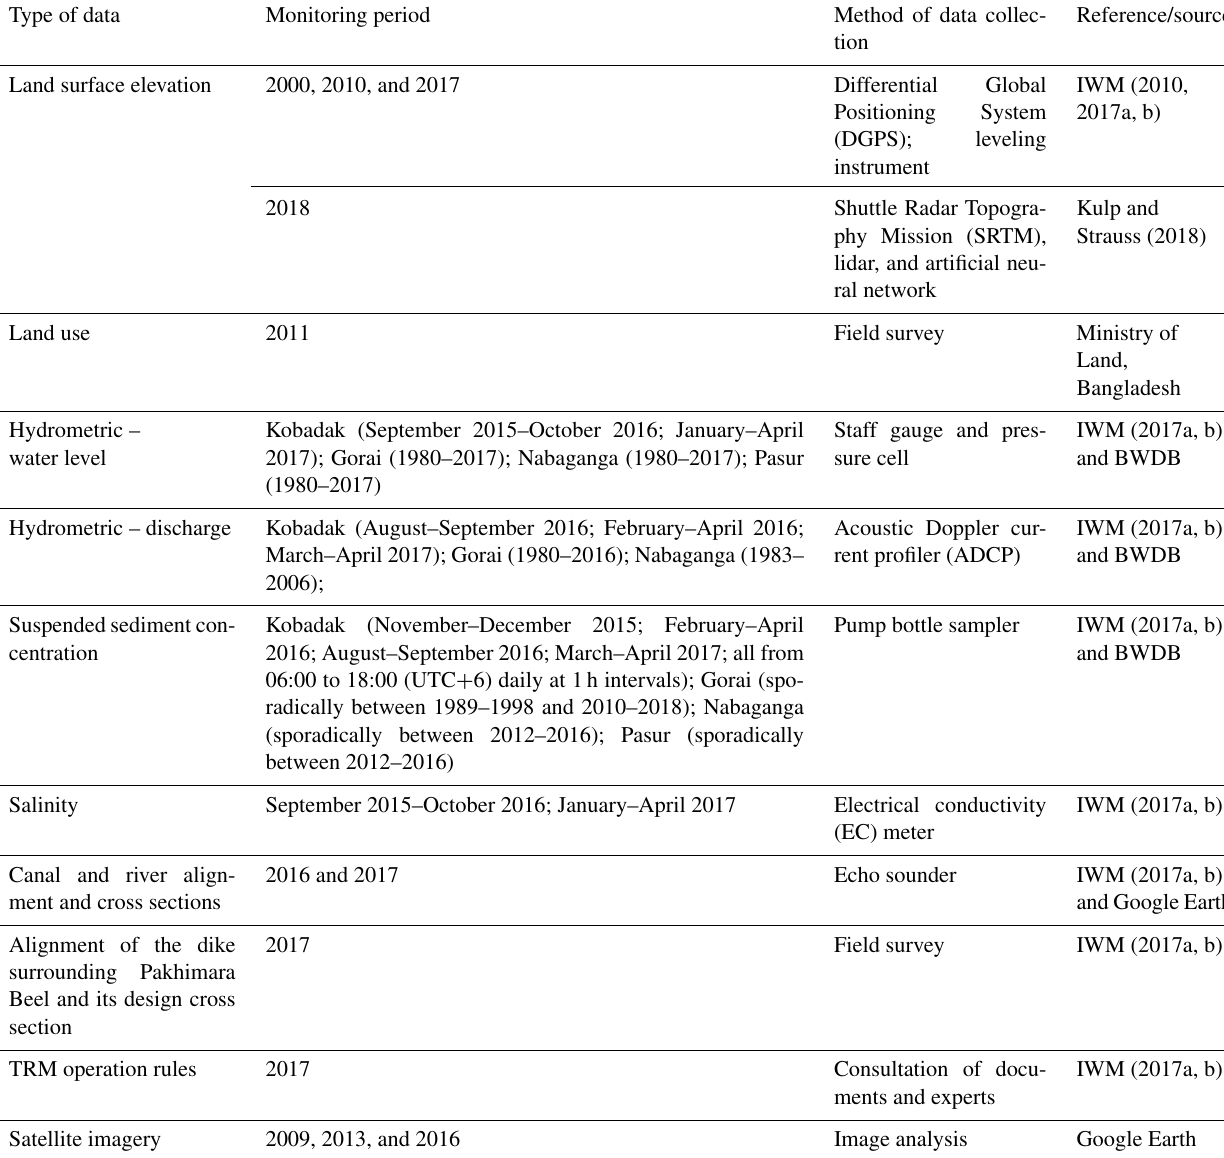
Table 1. Overview of data used in this